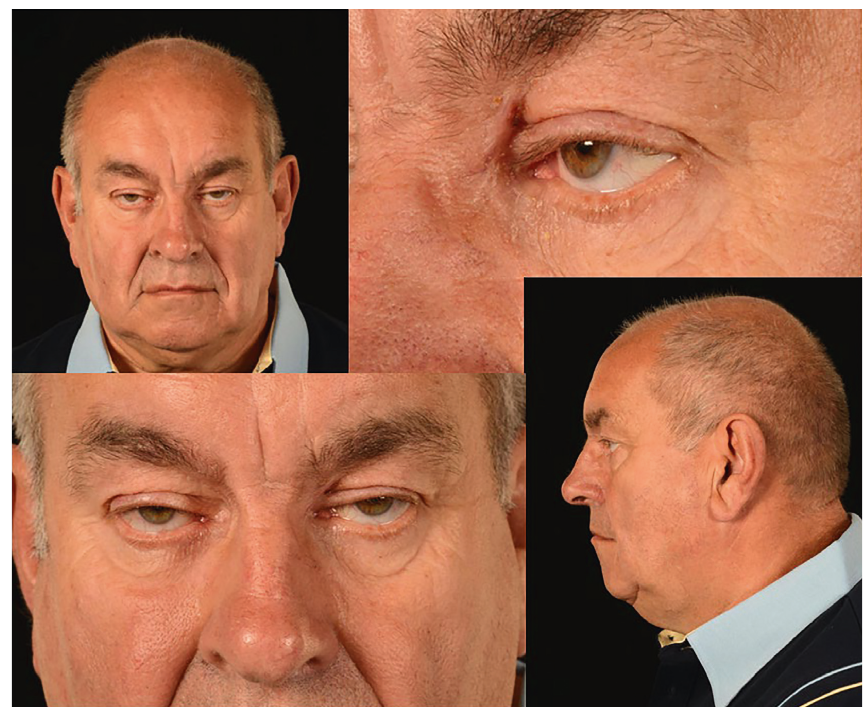
Figure 1: Preoperative images. Left fronto-orbital fistula draining into the supra-medial orbit.